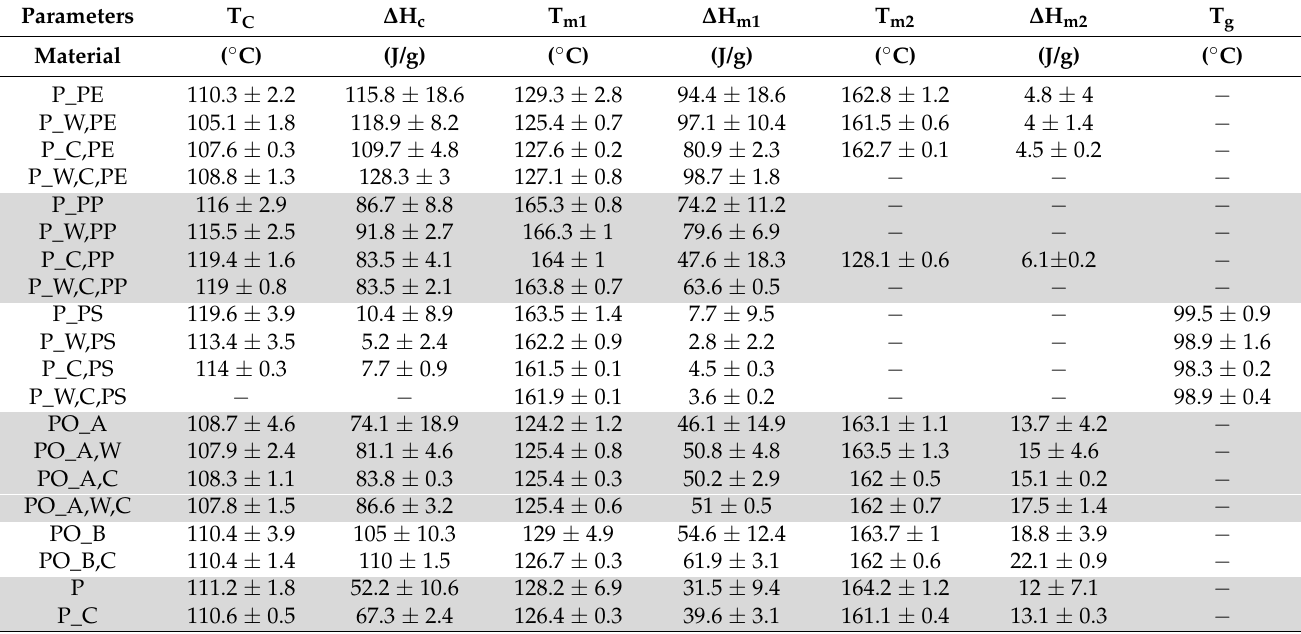
Table 1. Results of the DSC measurements: crystallisation temperature (T C ), crystallisation enthalpy ( ∆ H c ), melting temperatures (T m1 and T m2 ), melting enthalpy ( ∆ H m1 and ∆ H m2 ), and glass transition temperature (T g